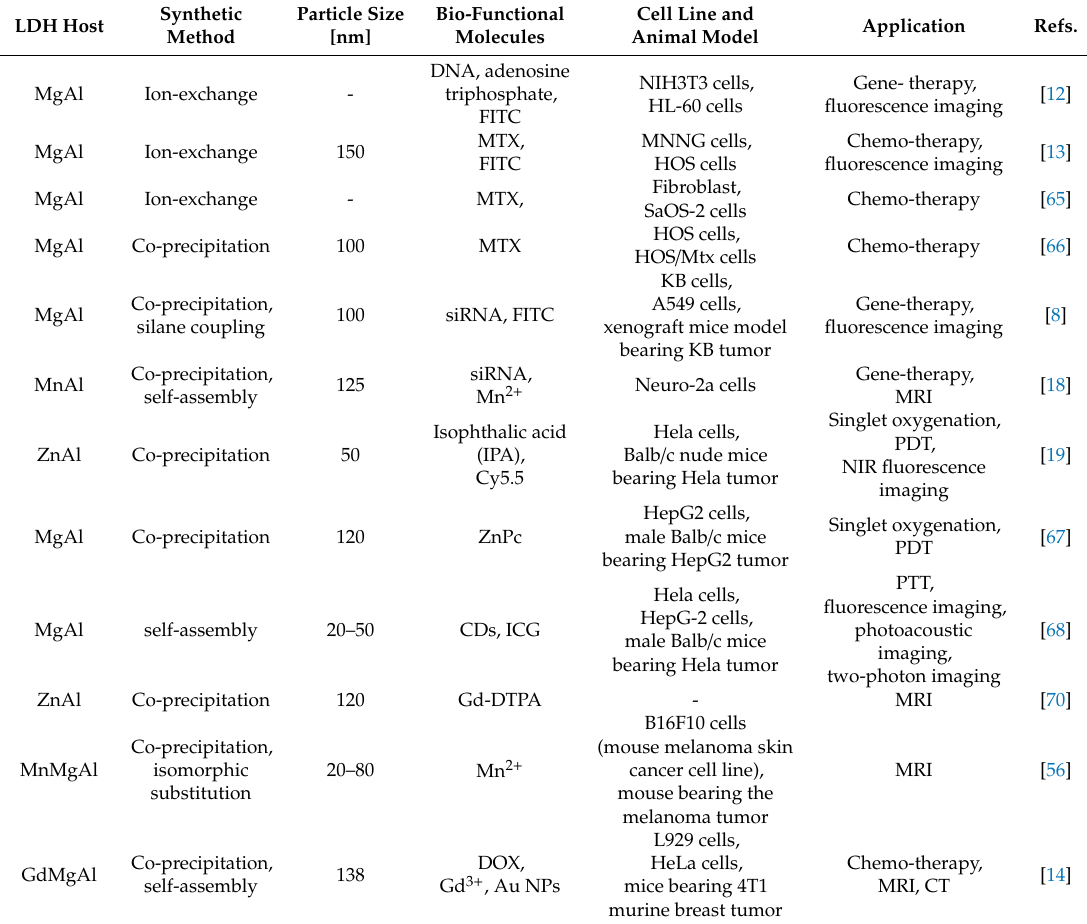
Table 1. A brief summary of hydrotalcite nanohybrids with biomedical